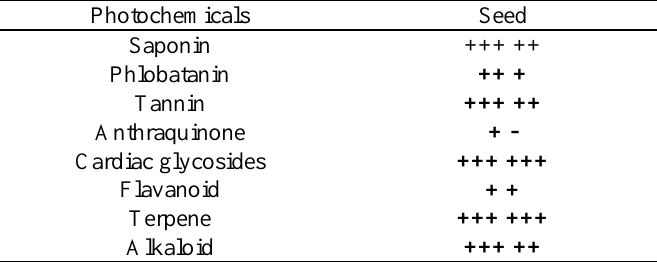
Table 5 . Phytochemical composition of ethanol extract of Azadirachta indica seeds